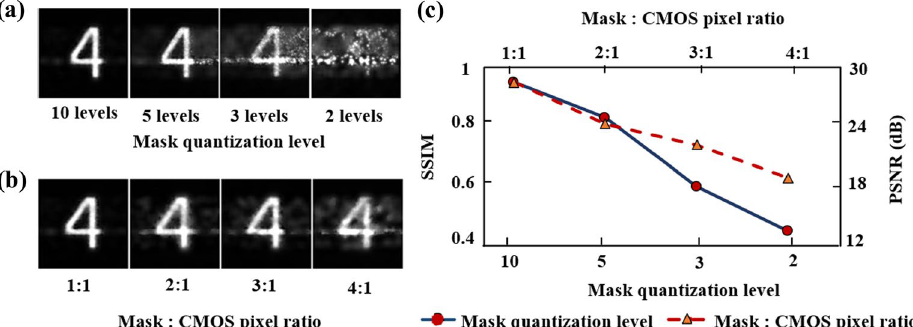
Figure 2. Reconstructed data ( a ) using various mask patterns quantised at different levels ( b ) at various Mask to CMOS pixel ratio. ( c ) SSIM and PSNR measurements for the figures shown at section ( a , b